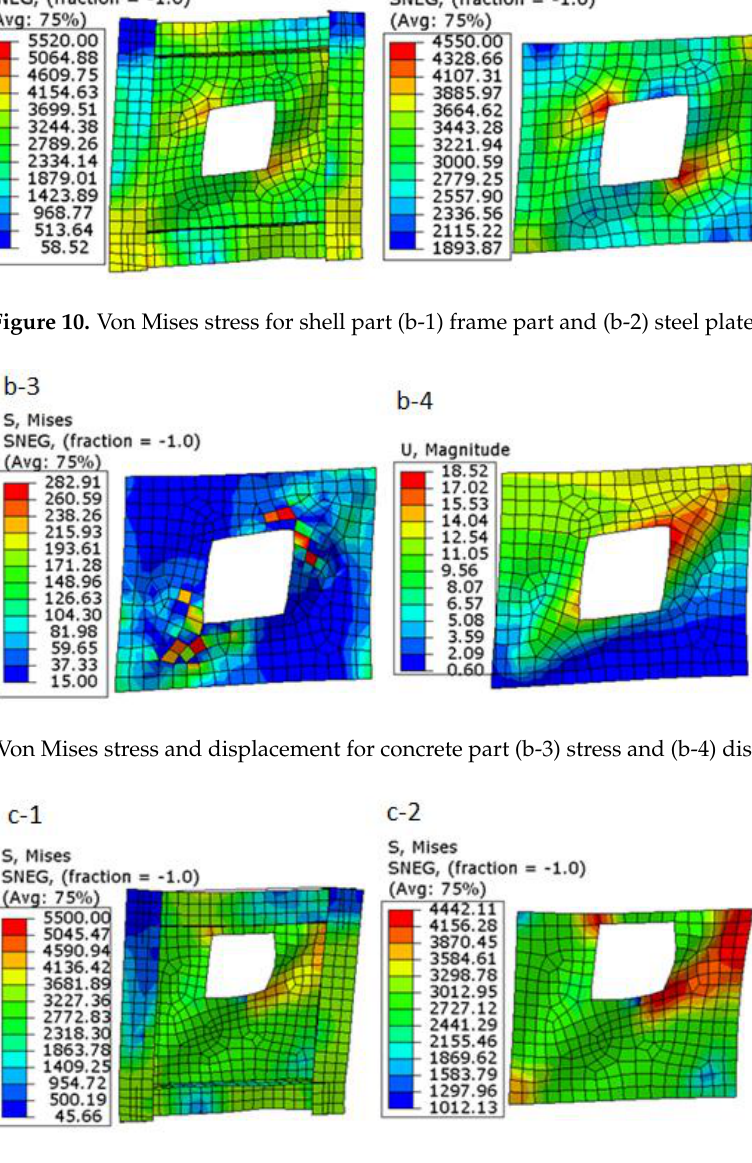
Figure 12. Von Mises stress for shell part (c-1) frame part and (c-2) steel plate.